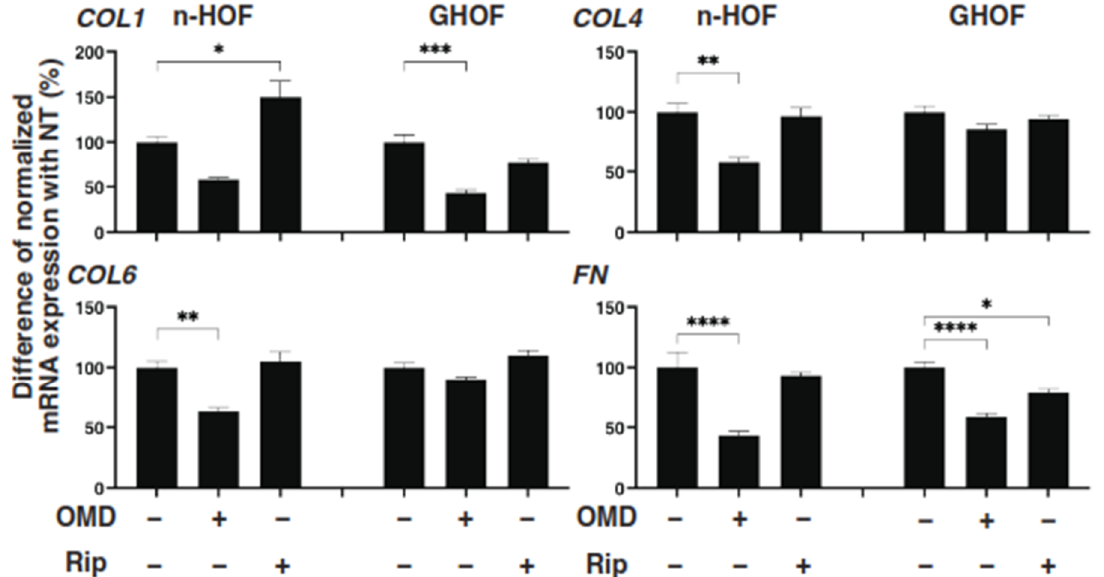
Figure 3. mRNA expression of ECMs in n-HOFs or GHOF 3D spheroids under several conditions. At Day 6, the n-HOFs 3D spheroids without or with 100 nM omidenepag (OMD) or 10 μM Ripasudil (Rip) were subjected to a qPCR analysis to estimate the mRNA expression of ECMs ( COL1 : collagen 1, COL4 : collagen 4, COL6 : collagen 6, Fn : fibronectin). Percentage difference in the mRNA expressions of these respective genes of n-HOF or GHOF spheroids treated with omidenepag (OMD) or ripasudil (Rip) as above, as compared with their non-treated control (CONT), were plotted. In terms of the results of the GHOF spheroids, corresponding data reported in our previous study [11] were recalculated and replotted. All experiments were performed in duplicate using fresh preparations, each of which consisted of 16 spheroids. Data are presented as the arithmetic mean ± standard error of the mean (SEM). * p < 0.05, ** p < 0.01, *** p < 0.005, **** p < 0.001 (ANOVA followed by a Tukey’s multiple comparison test).